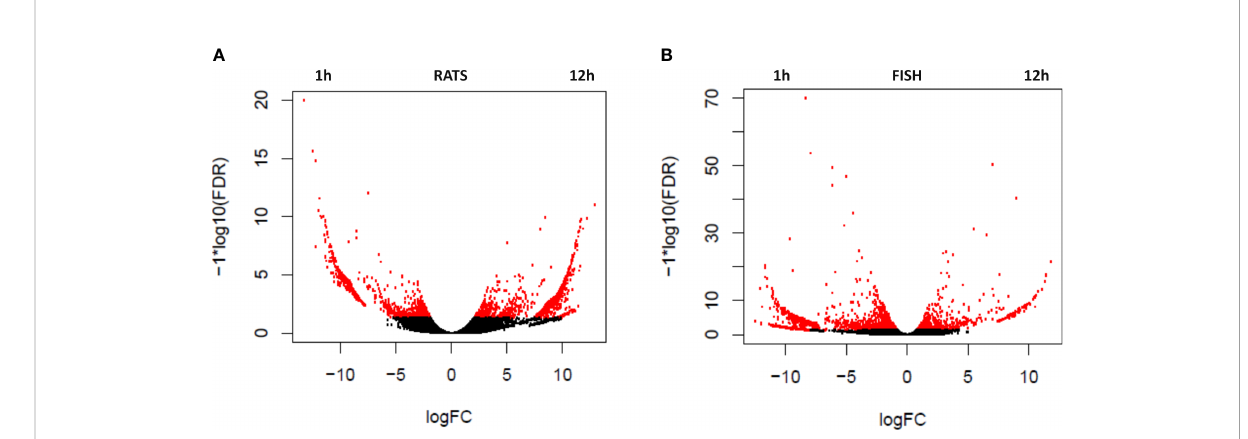
FIGURE 1 Volcano plots showing the relative expression levels of transcripts upregulated in the rat ( R. norvegicus ) (A) and fi sh ( D. labrax ) (B) peripheral blood leukocytes (PBLs) after 1 vs. 12 h of the treatment with A. pegref fi i crude extract. The x-axis represents the log2 of the expression ratio for each transcript, and the y-axis represents the log10 of the p-value corrected for the false discovery rate. Red dots represent DEGs with logFDR < 0.05 (at least twofold difference in logCPM). Positive logFC values indicate transcripts enhanced after 12 h of treatment, whereas negative logFC values indicate transcripts enhanced after 1 h.